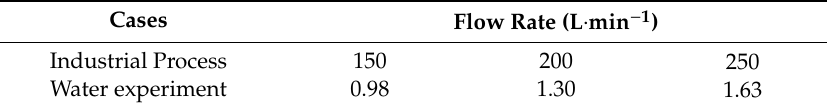
Table 2. Various flow rates in the industrial process and scaled values in the water experiment.